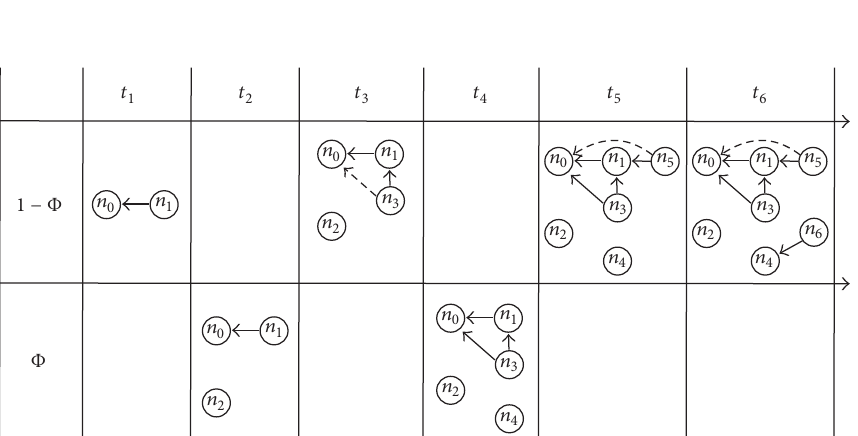
Figure 1: Growth of a directed network using the proposed model. Φ describes the probability for a new island emerges. At the beginning ( 𝑡 0 ), only node 𝑛 0 exists in the network. At the next time step ( 𝑡 1 ) node 𝑛 1 is added to the network and it is assumed that it connects to node 𝑡 𝑛 𝑛 0 . In 2 , node 2 is added and it is assumed that it does not connect to any node; thus a new island is generated. In assumed that it connects to 𝑛 1 and 𝑛 0 (dashed arrow) because 𝑛 0 has an incoming link from 𝑛 1 . In 𝑡 4 , 𝑛 4 generates a new island as 𝑛 2 in 𝑡 2 . At 𝑡 𝑛 𝑛 𝑡 5 and 6 , nodes 5 and 6 are added and connect to the network as